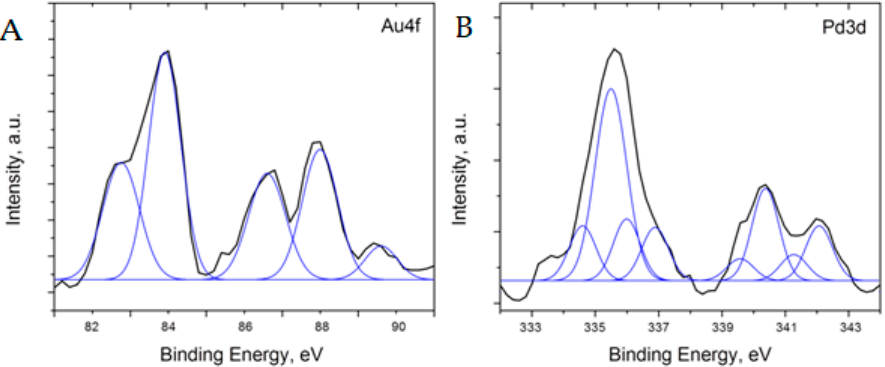
Figure 9. Core level XPS spectra of Au ( A) and Pd ( B ) after the charge and background correction for 5%Pd-1%Au/SiO 2 catalyst.